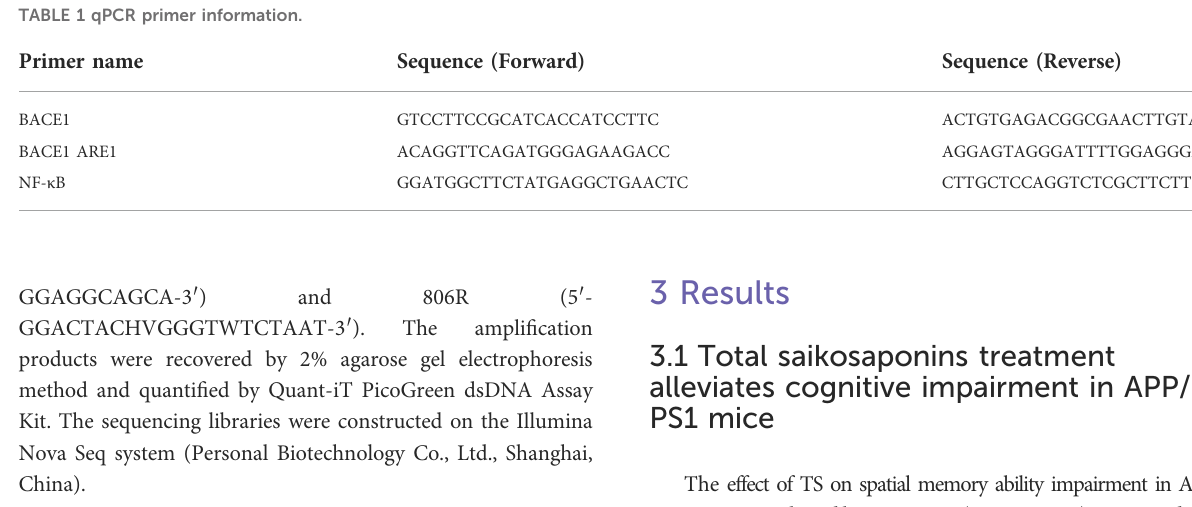
TABLE 1 qPCR primer